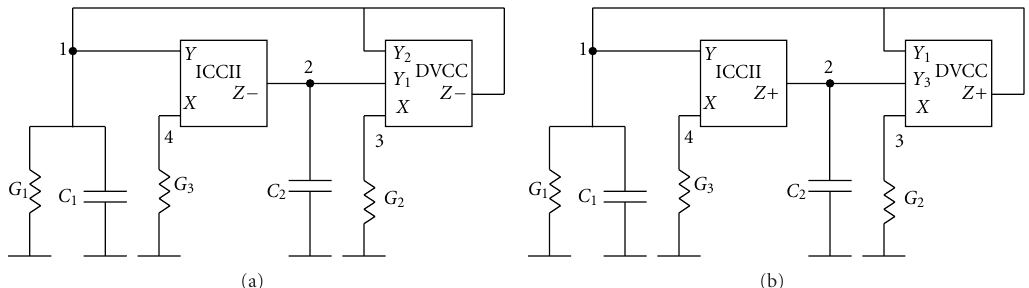
Figure 8: (a) Class II-Ad oscillator circuit realizing (44). (b) Class II-Ad oscillator circuit realizing (48).